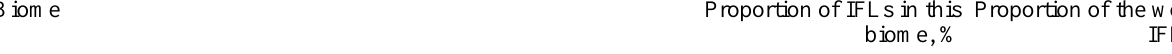
Proportion of the world’s biome, % IFLs, %